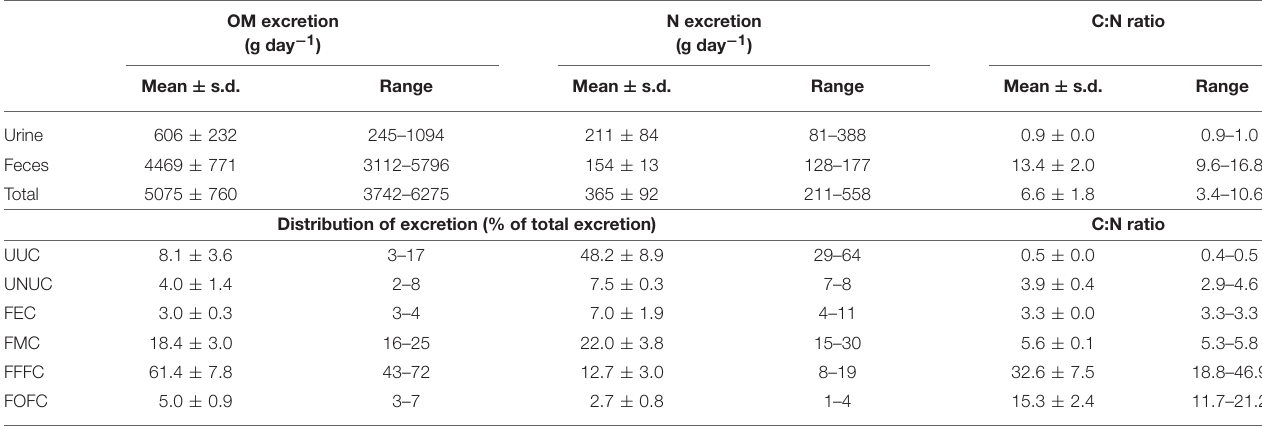
TABLE 5 | Mean values and ranges of simulated fecal and urinary organic matter (OM) and nitrogen (N) excretion, distribution of excretion between different components a and carbon to nitrogen (C:N) ratio of components for 40 nutritional strategies b for dairy cows.